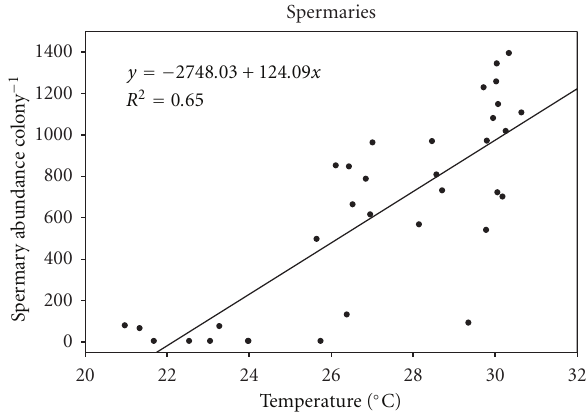
Figure 8: Simple regression of temperature and Solenastrea bournoni spermary abundance, including all stages per colony at each sample date. R 2 = 0 . 65, P < 0 .